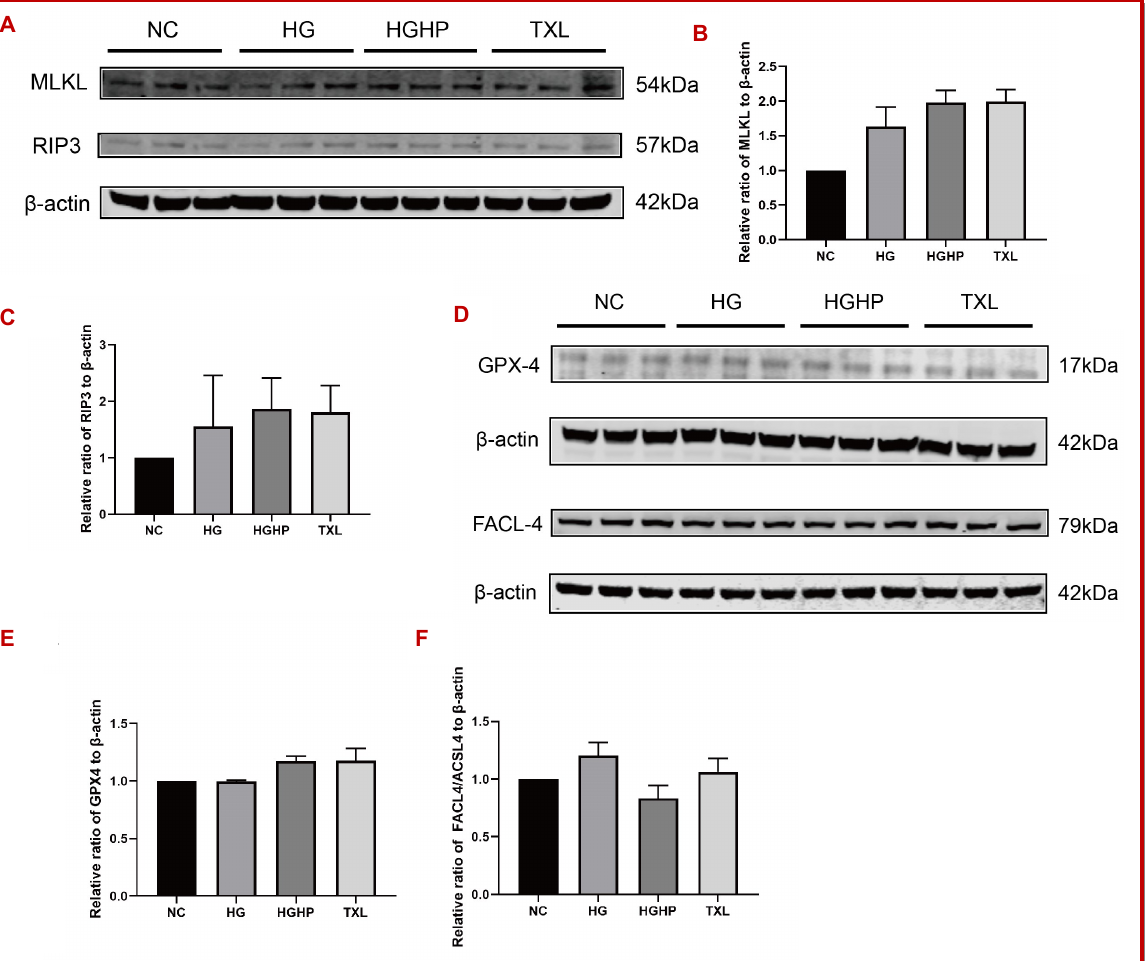
Figure 7: Effects of Tongxinluo (TXL) on necroptosis and ferroptosis in the HK-2 cells exposed to high-glucose (HG) and high- glucose combined with high-palmitic acid (HGHP). Representative band of MLKL, RIP3, GPX-4 and FACL-4 (ACSL-4) by West- ern blot in vitro (n=3 per group) (A, D); Semiquantitative analysis of average optical density of MLKL, RIP3, GPX-4 and FACL-4 (ACSL-4) (B, C, E, F). NC means normal control. The values represent means ±